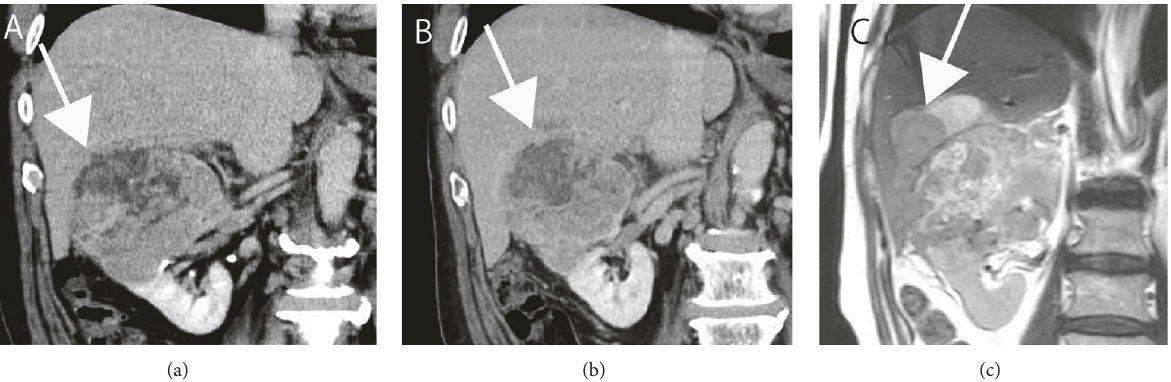
Figure 2: CT and magnetic resonance imaging (MRI) findings at the site of liver invasion . Appearance of invasion front (arrows) is shown before axitinib treatment (a), 2 months after treatment (b), and 3 months after treatment (c). Focal invasion is suspected at pretreatment period (a); however, invasion was progressed at 2 months after treatment (b), and apparent nodular formation was observed at 3 months